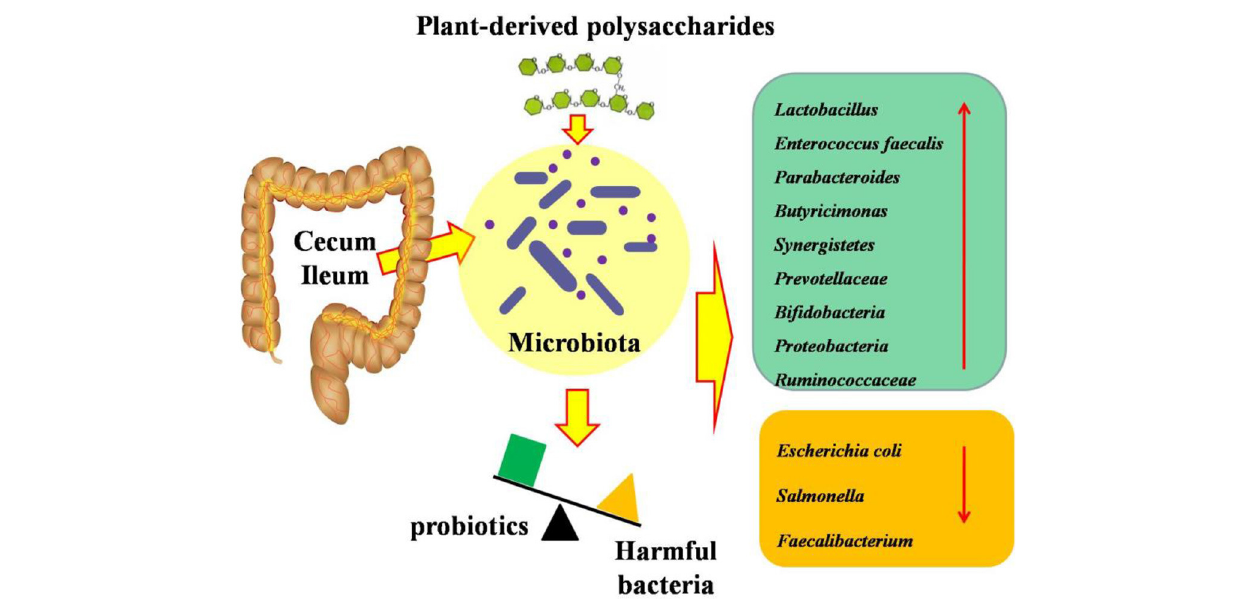
FIGURE 3 | Effects of plant-derived polysaccharides on intestinal microbiota in ileum and cecum of broilers.